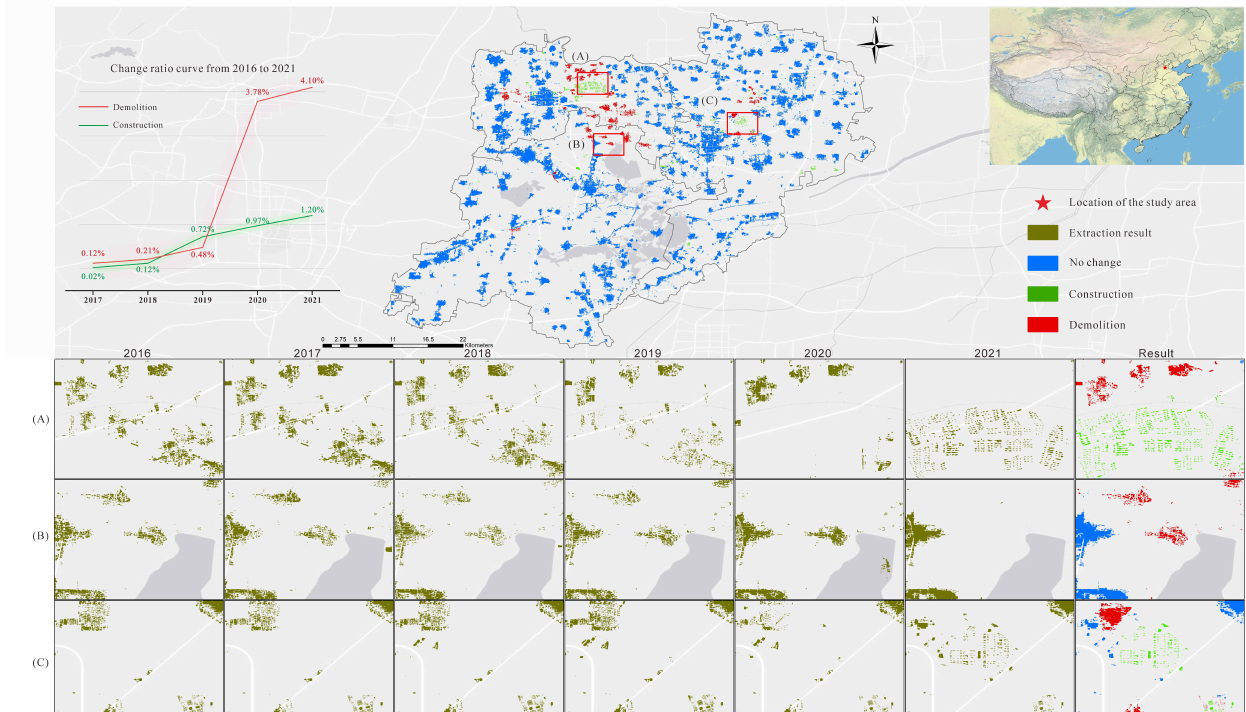
Figure 17. Dynamic building-change-tracking results (2016–2021) of the Xiong’an New area in China. The subplots ( A – C ) are three detail examples to show the building